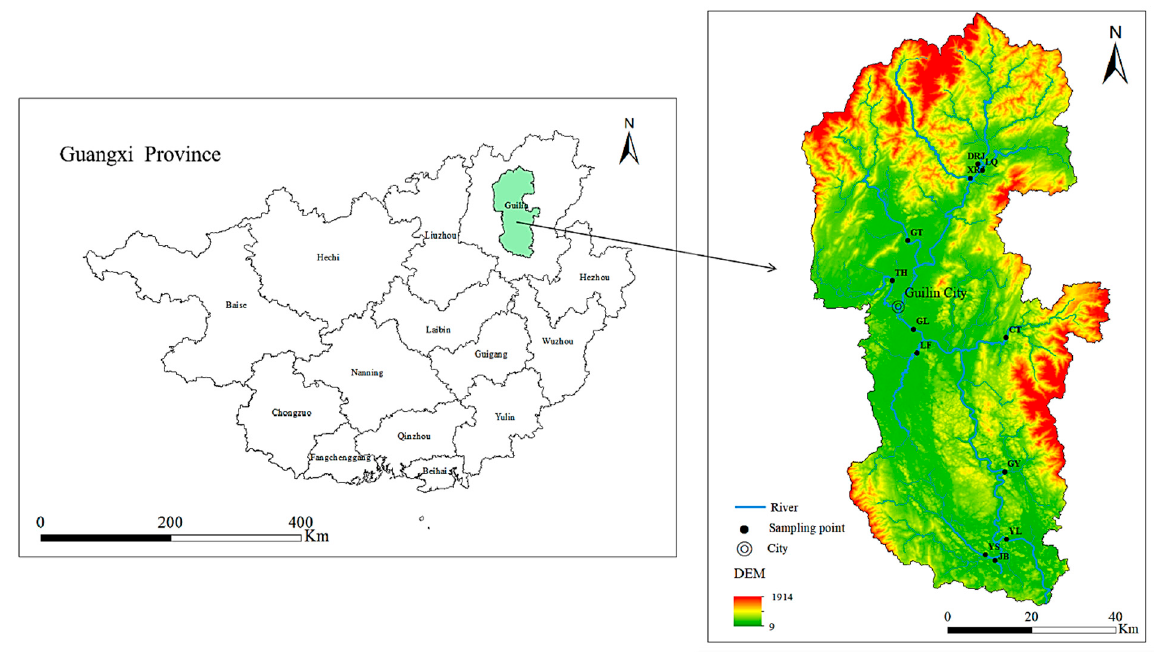
Figure 2. Study area and distribution of sampling points.